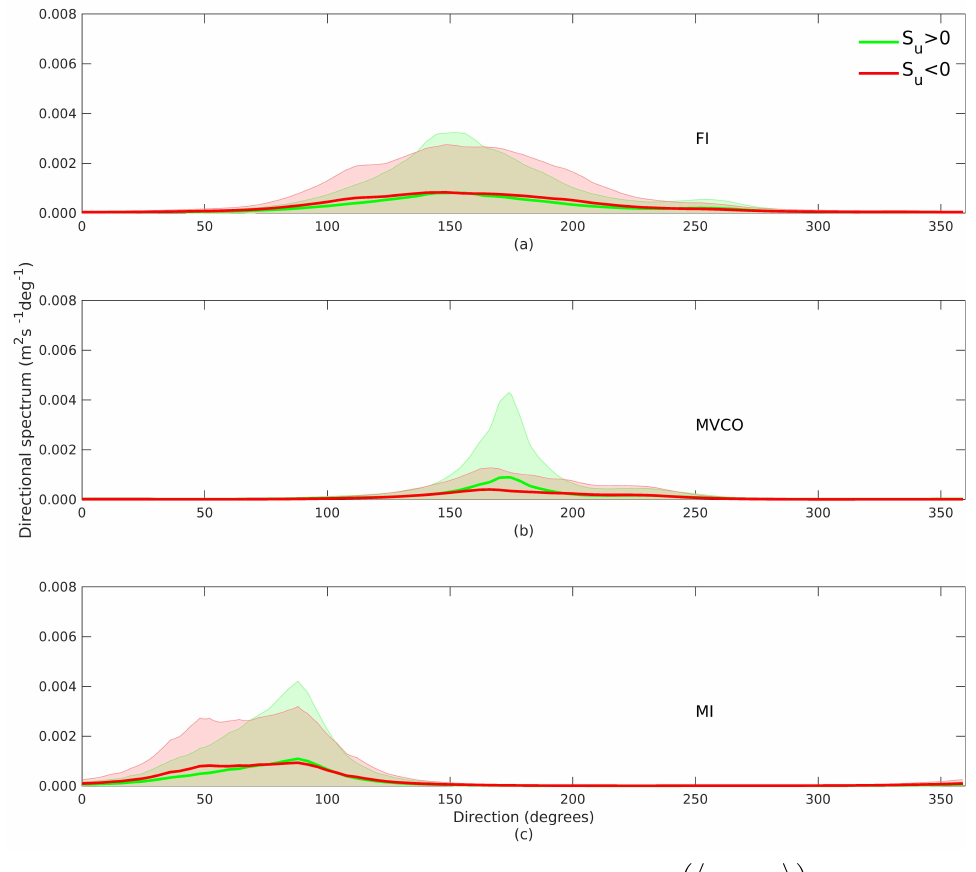
Figure 9. Directional wave spectrum averaged over all frequencies ( a ) Fire Island site, ( b ) MVCO site, and ( c ) Matanzas Inlet site. Mean values are indicated by bold lines and shaded regions highlight the standard deviation of wave spectrum. Green bold lines and shaded region bin the events associated with positive wave-orbital velocity skewness. Red bold lines and shaded region bin the events associated with negative